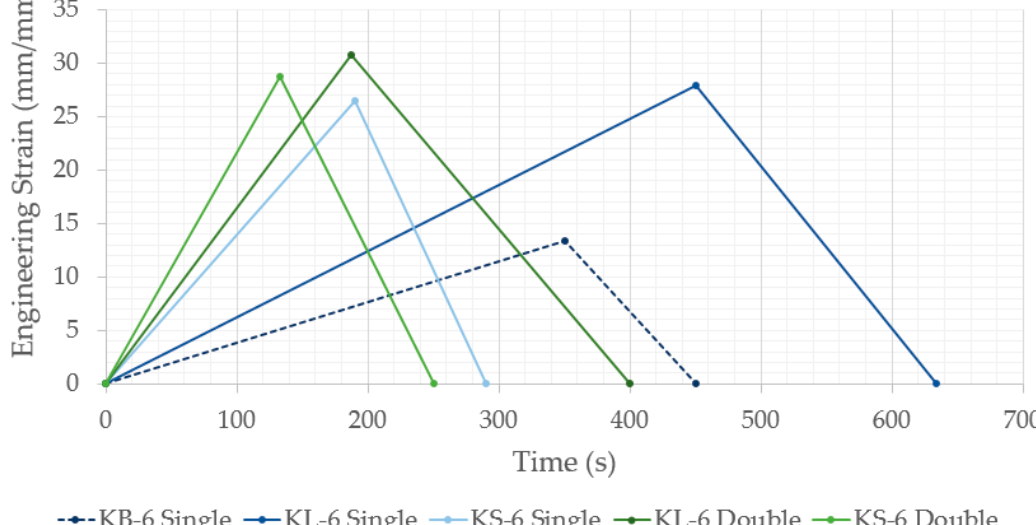
Figure 8. Actuation strain. One actuation cycle of each type fabric, denoting the maximum strain of each actuator and the actuation time to reach that point. It was assumed that once the actuator was cooled down, the final dimensions would be roughly the same as the initial dimensions. In terms of peak actuation speed, the KB-6 design achieved 0.0022 Hz, the KL-6 design achieved 0.0025 Hz, and the KS-6 design achieved 0.0040 Hz.